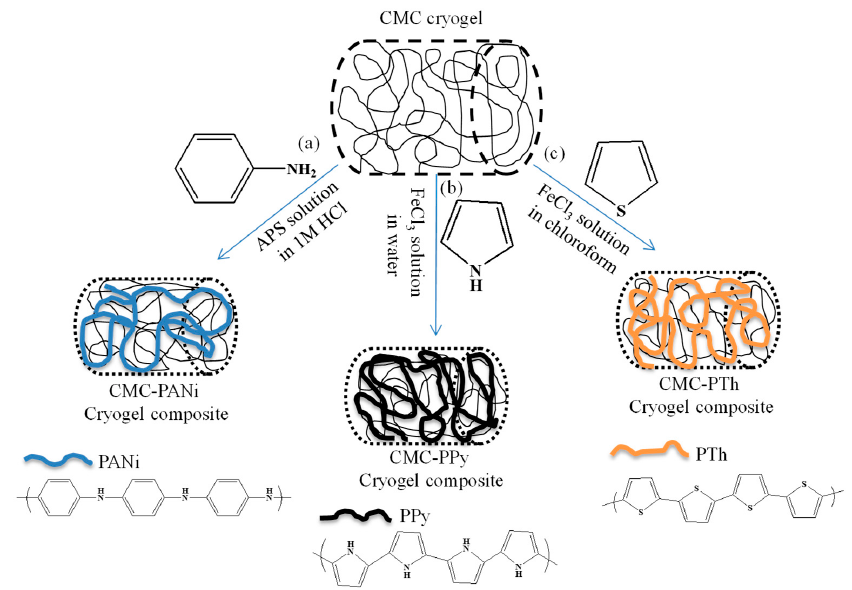
Figure 1. The schemcatic presentation of in situ synthesis of ( a ) poly(Aniline) (PANi), ( b ) poly(Pyrrole) (PPy), and ( c ) poly(Thiophene) (PTh) conductive polymers within carboxymethyl cellulose (CMC) cryogels. APS, ammonium persulfate.